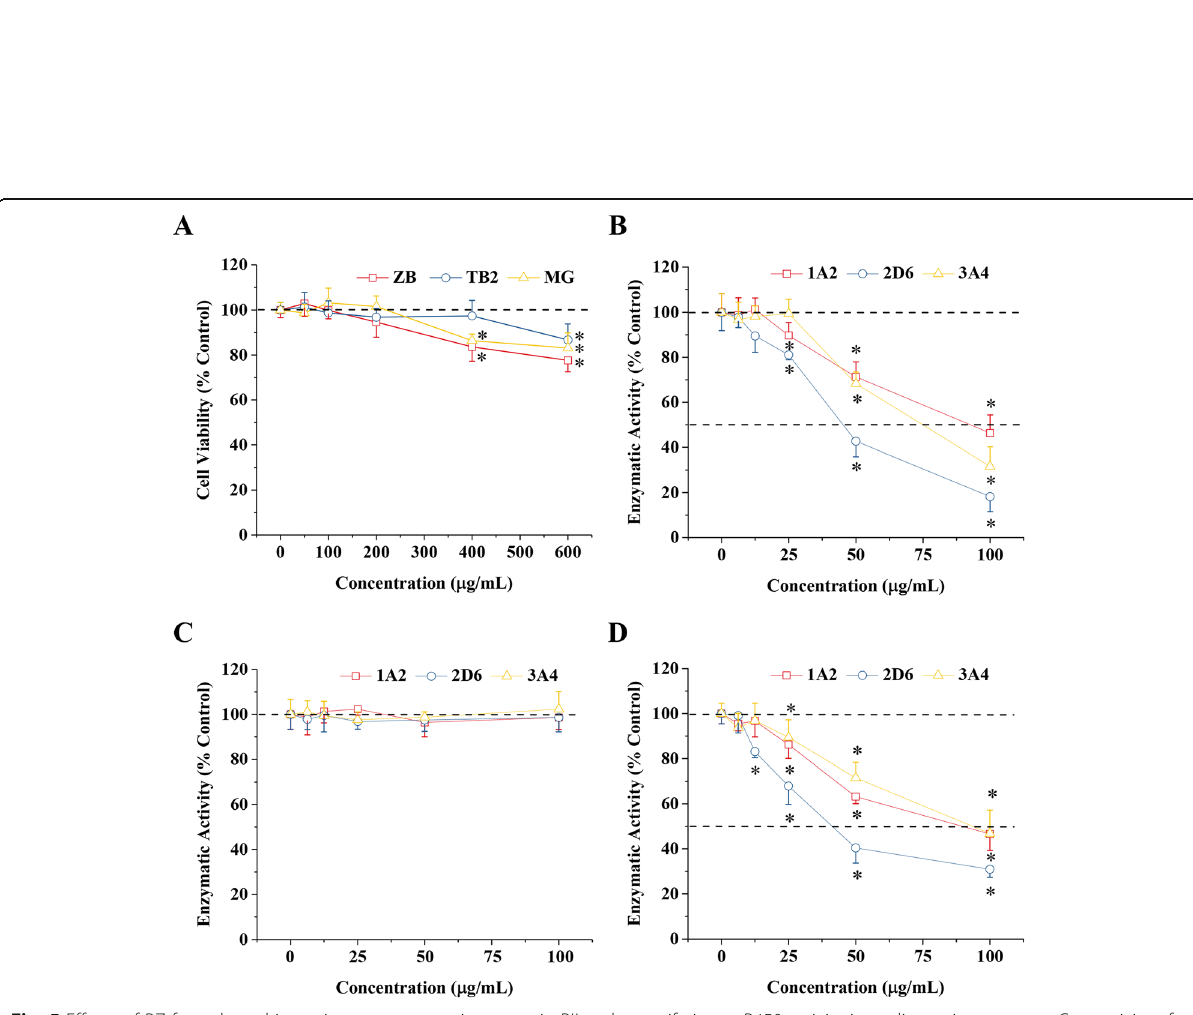
Fig. 5 Effects of BZ formula and its main components, timosaponin BII and mangiferin, on P450 activity in rat liver microsomes. a Cytotoxicity of BZ formula and its main components on human L02 hepatocytes was measured 48 h after treatment using the MTT test. The effects of b BZ formula, c timosaponin BII, and d mangiferin on P450 activity in rat liver microsomes. After a 1-h incubation, the microsomes were exposed to the indicated concentrations of BZ formula, timosaponin BII, or mangiferin. Results are expressed as the percentage of cell viability compared to the controls (untreated microsomes). Each point represents the mean ± SD of three replicates. * p < 0.05 compared to the vehicle group based on one-way